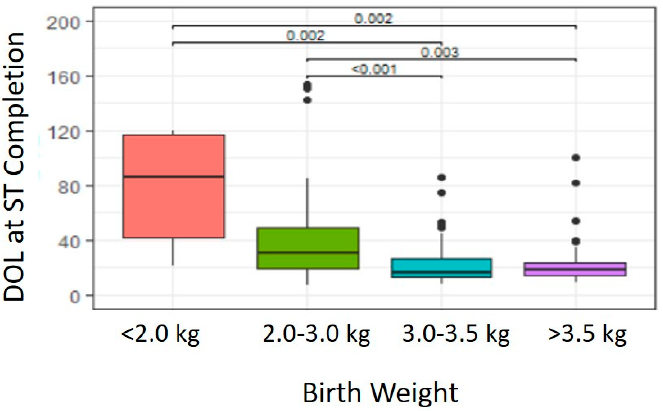
Figure 1. Effect of Birth Weight on Age at Successful Completion of Sweat Chloride Testing.